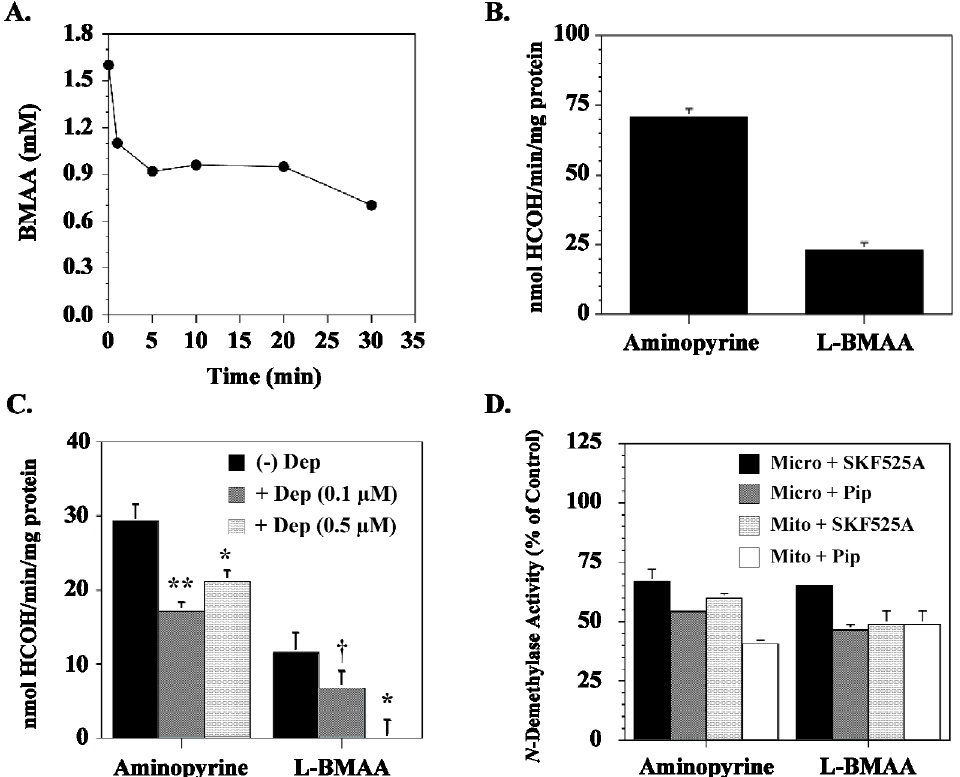
Figure 5. Metabolism of L-BMAA by the brain cytochrome P-450-dependent N -demethylase. ( A ) Disappearance of L-BMAA after incubation with rat cerebral microsomes 1 ; ( B ) Metabolism of L-BMAA by crude microsomes derived from mouse cortical explants 2 ; ( C ) Effect of the N -demethylase inhibitor deprenyl on the metabolism of L-BMAA by rat cerebral microsomes 3 ; ( D ) Effect of the cytochrome P450 inhibitors SKF525A and piperonyl butoxide on the metabolism of L-BMAA by rat cerebral microsomes and mitochondria 4 . Graphs derived from Kisby et al. [43] and unpublished